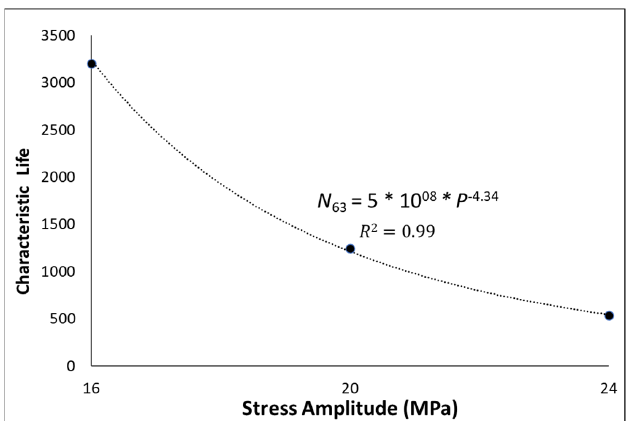
Figure 9. Characteristic life as a function of stress amplitude for SAC305 solder joints at no dwelling.